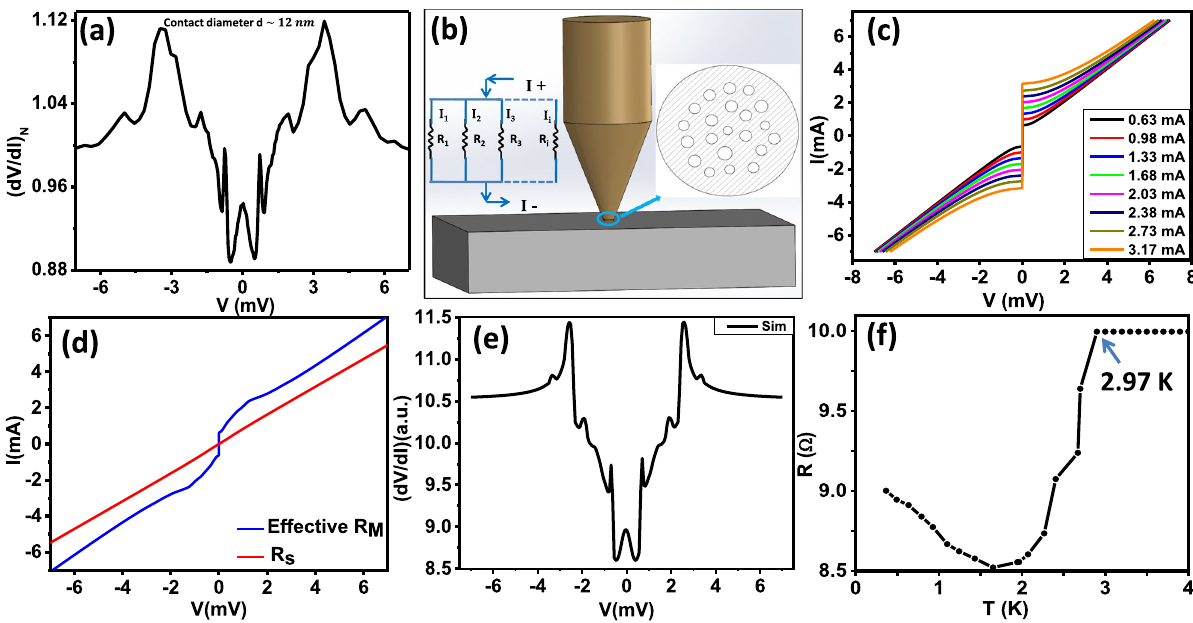
Figure 2. ( a ) Normalized ( ( dV / dI ) N ) spectrum obtained in the intermediate regime of transport showing the characteristic signatures of critical current peaks and Andreev reflection (AR) dips. ( b ) Schematic of point contact setup. Inset shows the assembly of microconstriction of different diameter and the effective electrical circuit. ( c ) I – V characteristics corresponding to Maxwell’s resistance for different values of I C . ( d ) I – V characteristics corresponding to Sharvin’s resistance calculated from the BTK model (red) and effective Maxwell’s resistance (blue). ( e ) Calculated dV / dI vs V spectrum of the modelled electrical circuit. ( f ) Zero bias resistance ( R ) vs. T of the point contact in intermediate